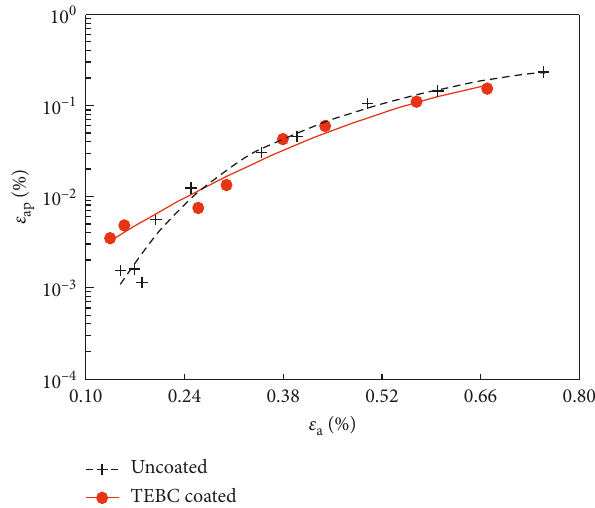
Figure 7: Plastic strain amplitude ε amplitude ε a